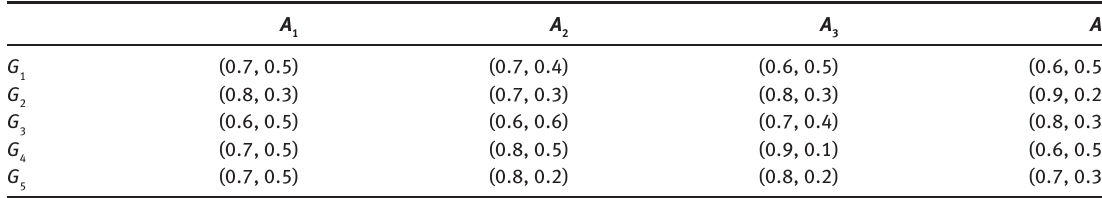
Table 3: Pythagorean Fuzzy Decision Matrix D 3 .